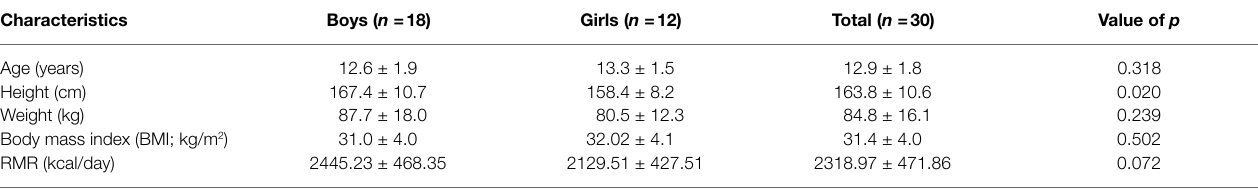
TABLE 1 | Baseline participant characteristics.